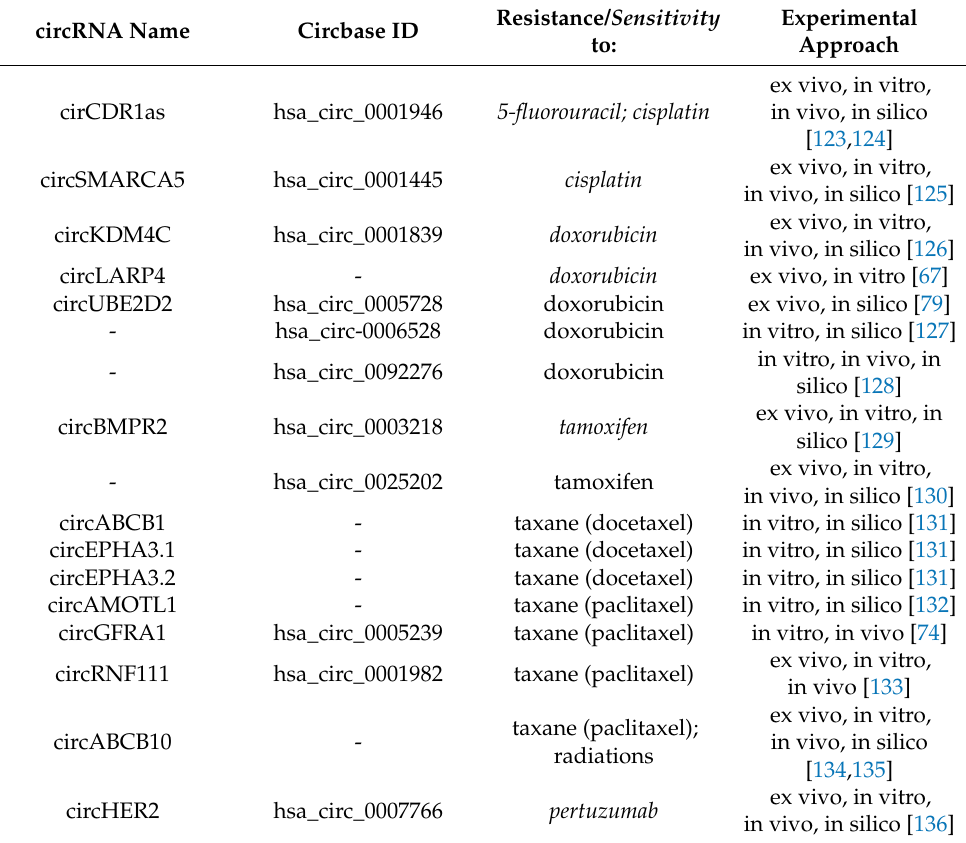
Table 3. List of circRNAs involved in resistance to BC